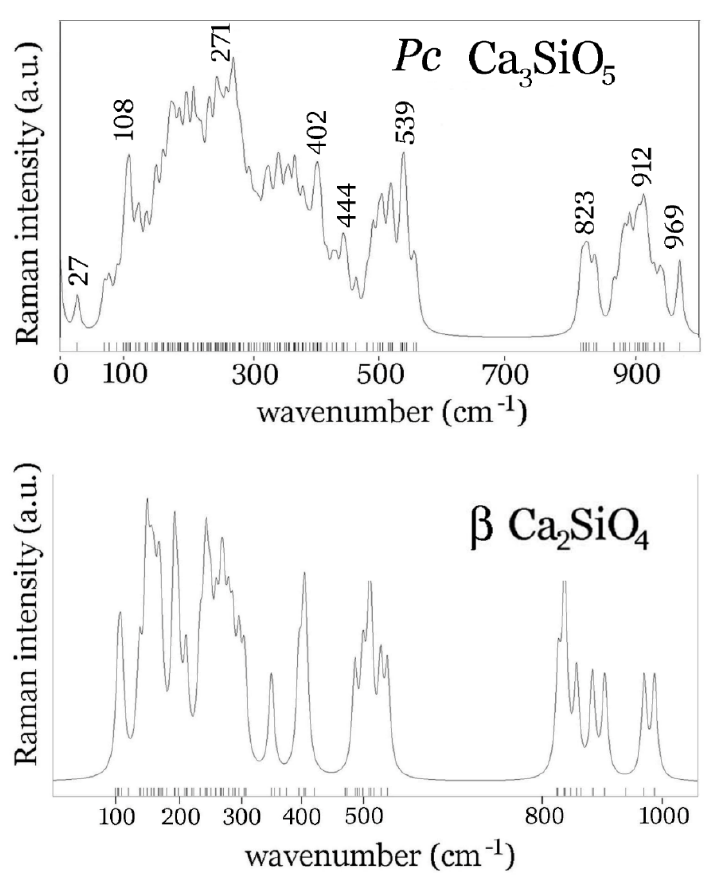
Figure 2. Calculated phonon density of states for Ca 3 SiO 5 and Ca 2 SiO 4 crystals.